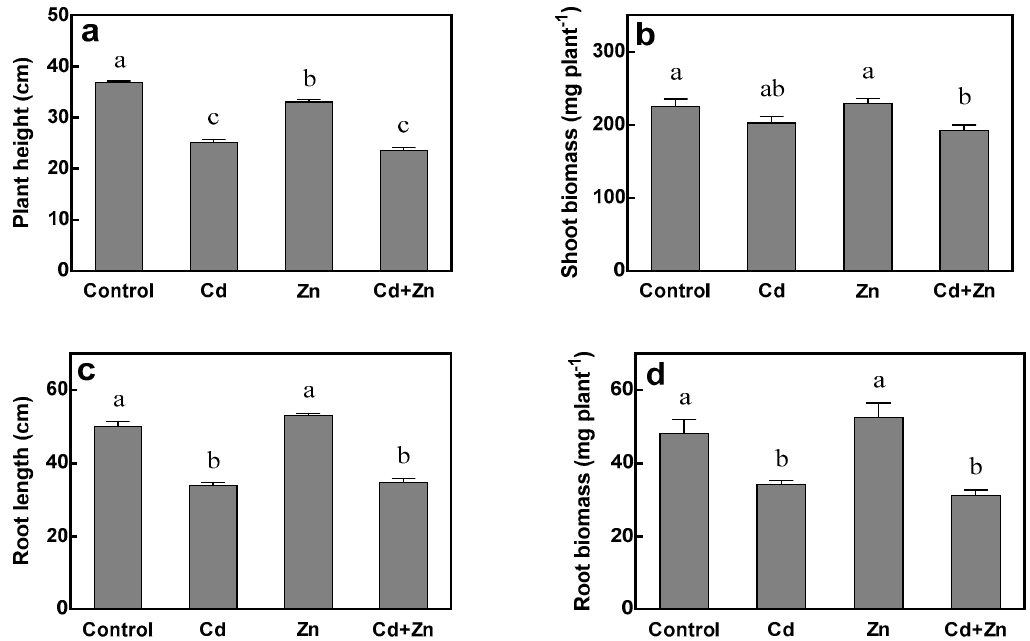
Figure 1. Plant height ( a ), shoot biomass ( b ), root length ( c ) and root biomass ( d ) of tall fescue grown for 15 days in solutions under control (0 µ M Cd + 15 µ M Zn), Cd (75 µ M Cd + 15 µ M Zn), Zn (0 µ M Cd + 115 µ M Zn) and Cd + Zn (75 µ M Cd + 115 µ M Zn) treatments. Error bars represent ± SEM of three replicates. Means with a common letter did not differ significantly (Duncan’s test, p < 0.05). The two-way analysis was performed.